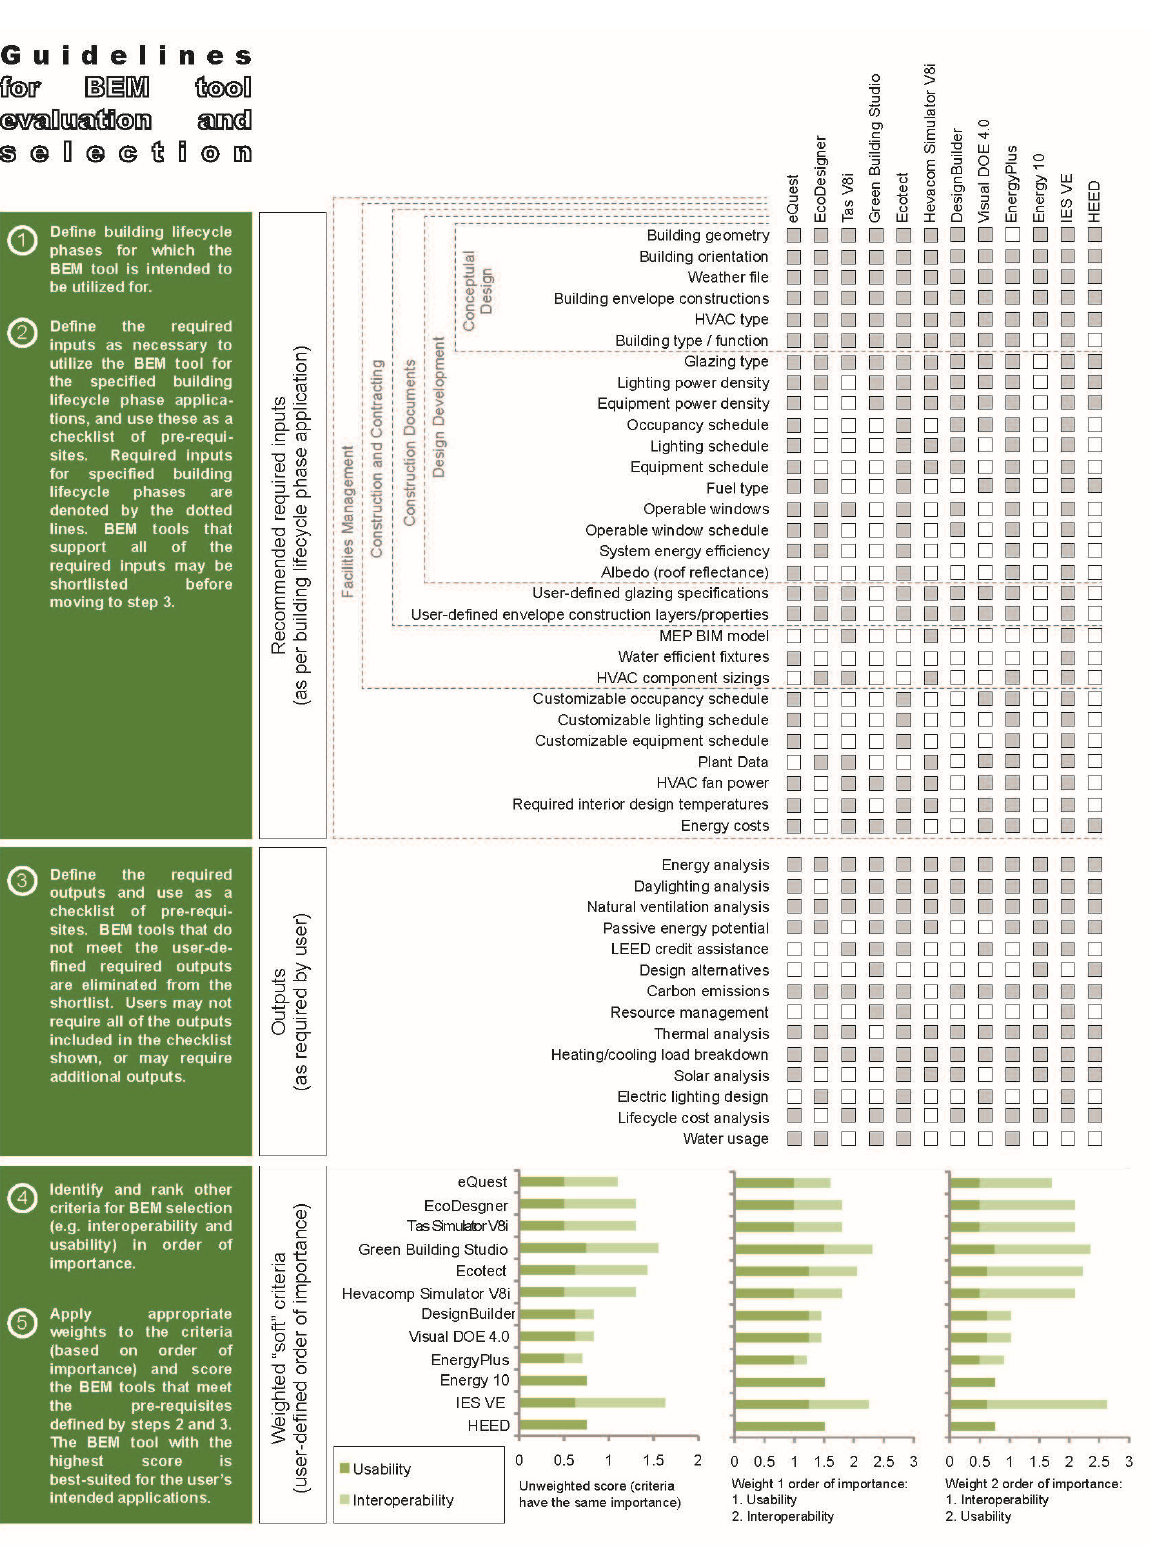
Figure 6. Guidelines for BEM tool evaluation and